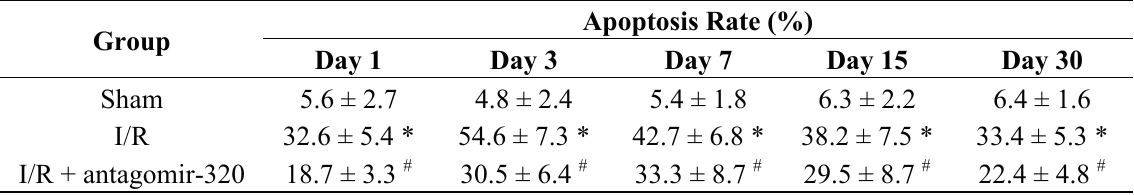
Table 3. The apoptosis rate of myocardial cells in three groups by terminal dUTP nick end-labeling (TUNEL) staining.